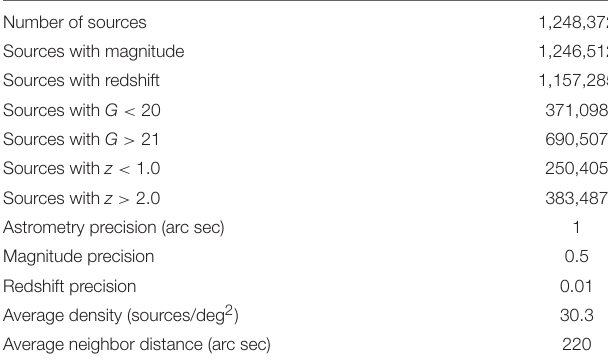
TABLE 1 | Properties of the Initial quasar catalog with numbers of different sources and their expected typical precision, adapted from Andrei et al.